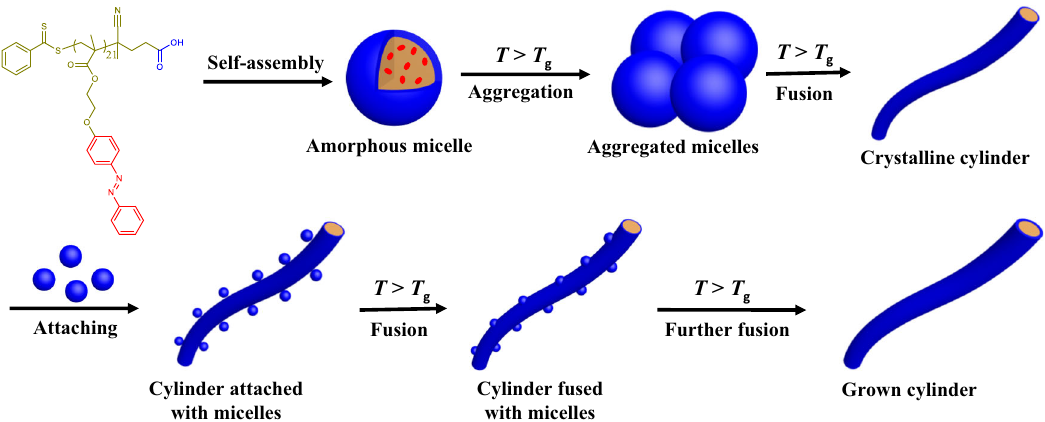
Fig. 1 Self-assembly of PAzoMA to form spherical micelles and living lateral growth of cylinders by CD-FIPA of micelles. PAzoMA homopolymer can self-assemble into amorphous spherical micelles, which aggregate and fuse to form crystalline cylinders when incubated at 75 °C. With the addition of spherical micelles, the micelles attach onto and fuse with the cylinders, leading to the living lateral growth